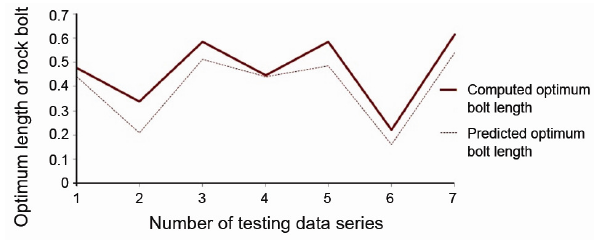
Fig. 4. The performance of the optimal model, 6-18-3-1